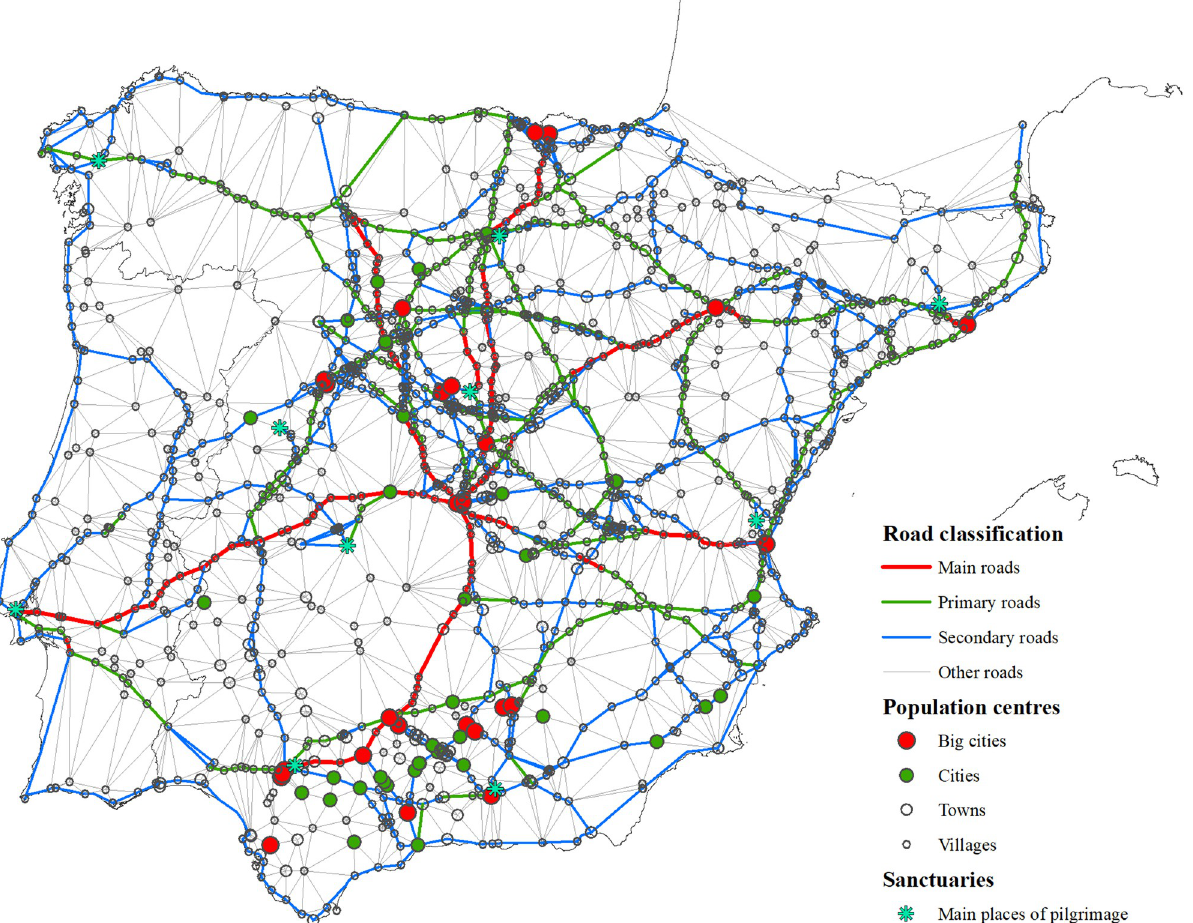
Fig 10. The Iberian Road map of the late 16th century. Notes: The categorization of the roads was done following the same methodology as in Fig 9. In red are the main sections of road that appear in at least six of the eight sources, in green the primary roads that appear in four or five, in blue the secondary roads that appear only in three or less, and finally in gray those artificially generated in the model and do not appear in any known source. Sources : Produced by the authors from D’Ocampo [107], Villuga [63], Estienne [108], Gail [109], Stella and L’Herba [110], Meneses [64], Rowlands [111], and Hogenberg [112]. Base map from the Centro Nacional de Informacio´n Geogra´fica (Spain).